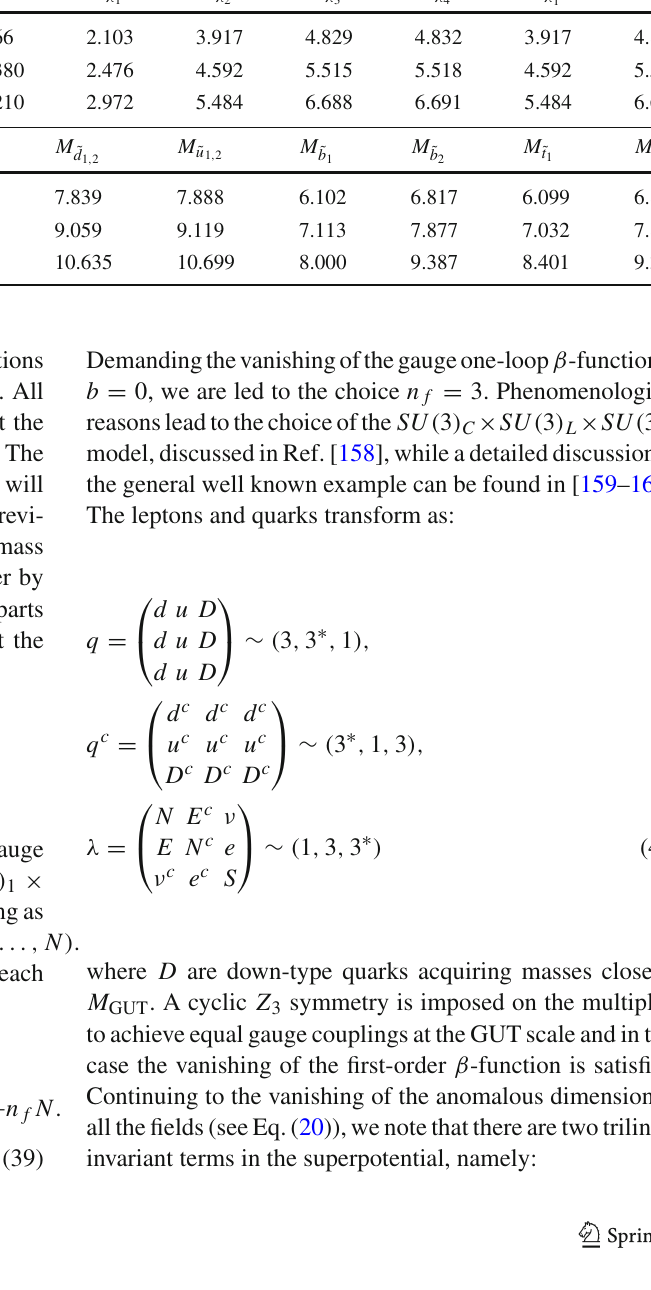
Table 5 Masses for each benchmark of the Finite N = 1 SU ( 5 ) (in TeV) M H M